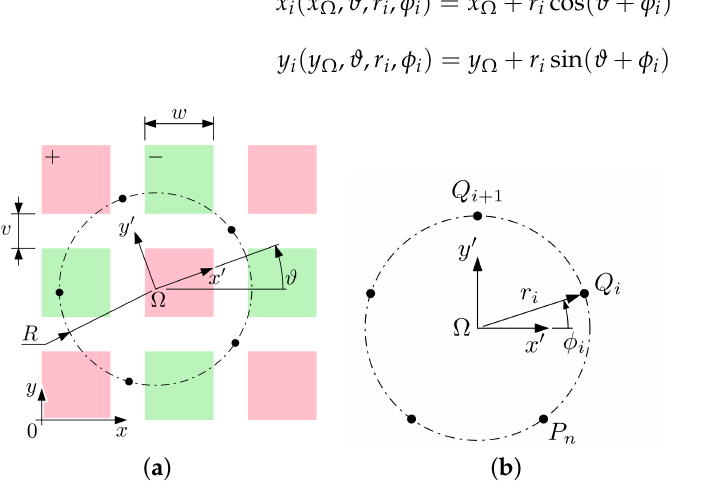
Figure 2. Positions of the 5 robot pins with respect to the conducting pads, in the inertial ( a ) and in the robot ( b ) reference